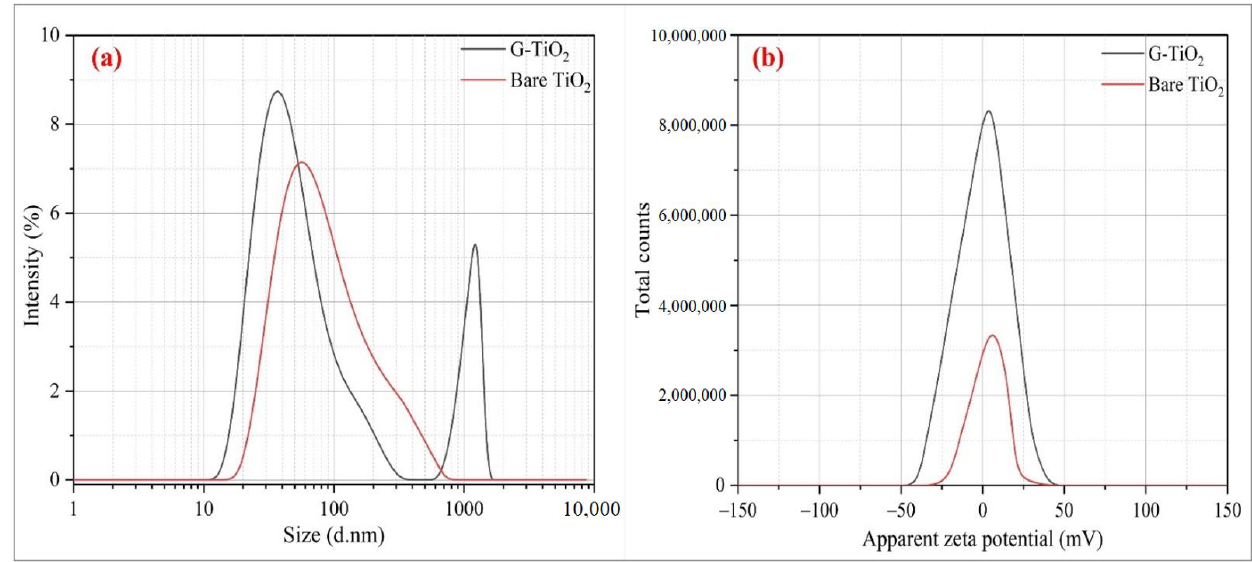
Figure 5. DLS analysis ( a ) particle size distribution ( b ) apparent zeta potential of biosynthesized and bare TiO 2 nanoparticles.